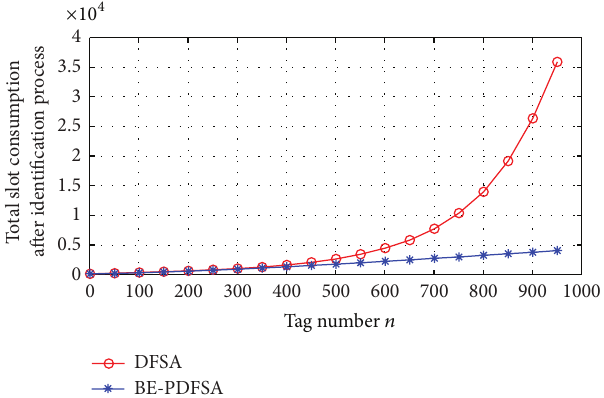
Figure 4: Comparison of total source consumption in identification